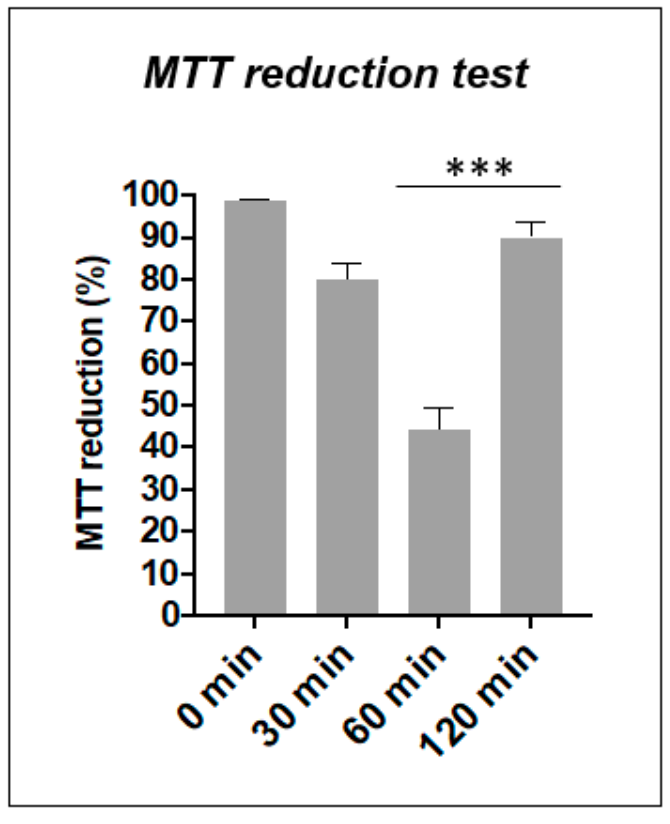
Figure 4. MTT reduction test. MTT reduction test of T cells treated with 0.3 mM diamide. Reduction activity is expressed as percent of untreated cells (N = 3). *** ( p < 0.001) indicates the incubation time that determines a statistically significant change between samples measured by student T -test.